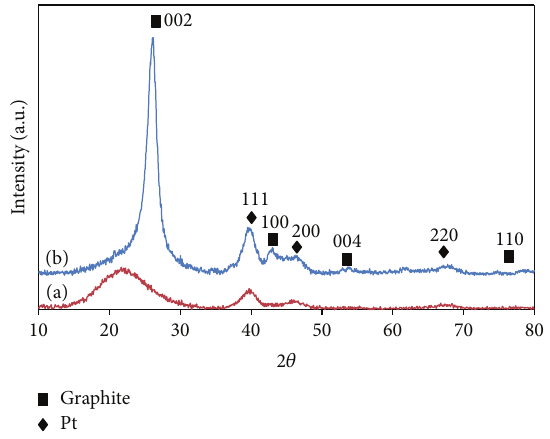
Figure 1: XRD patterns of (a) 3.5 wt% Pt/RGO@SiO 2 and (b)